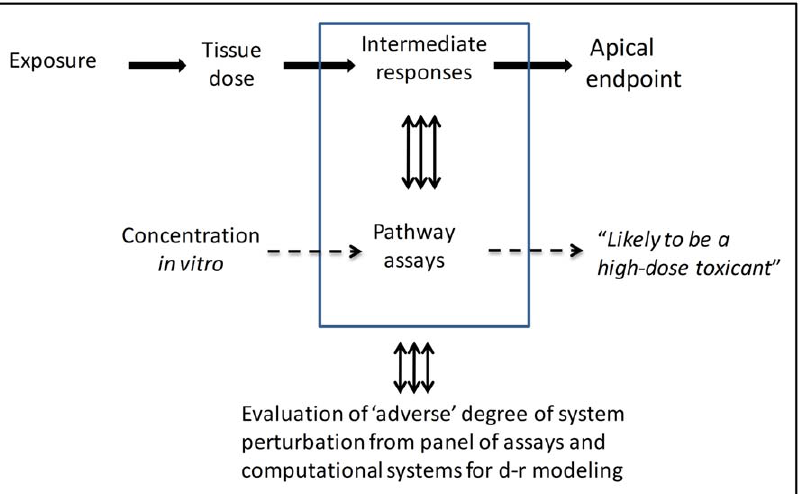
Figure 6. Using prototype pathways and compounds: the fast track for implementing the 2007 NRC TT21C vision. The next step in moving forward will be to see the entire 2007 TT21C vision placed in practice with a group of pathways and specific prototype compounds preferentially affecting the target pathways. The use of compounds with robust animal toxicity profiles will allow a mapping of in vivo responses associated with apical end points and intermediate end points against new in vitro toxicity pathway assay results. The comparison will permit a better sense of the relationship between in vitro and in vivo responses in key pathways and the relevant estimates of risk. Prototype compounds for the DNA-damage pathway could include DNA-damaging compounds – polyaromatic hydrocarbons, formaldehyde, and alkylating agents, etc. – and compounds causing DNA damage indirectly through oxidative stress pathways, such as flavonoids. The output of the two approaches in relation to risk estimates and estimates of safe region of exposure could also be compared to assess correspondence or lack of correspondence in the approaches.